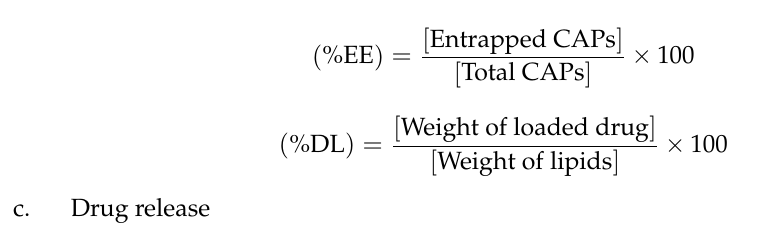
ANOVA Multiple Comparisons LSD